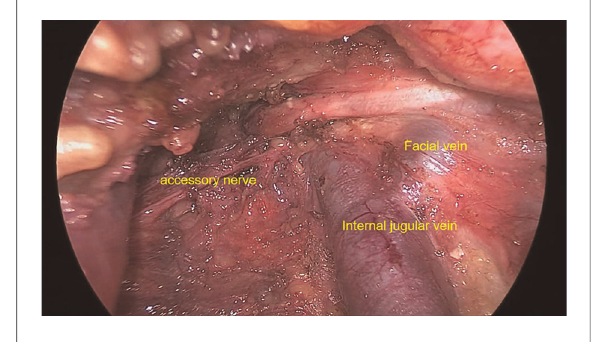
FIGURE 1 Area II lymph node dissection via trans-thoracoareolar approach.